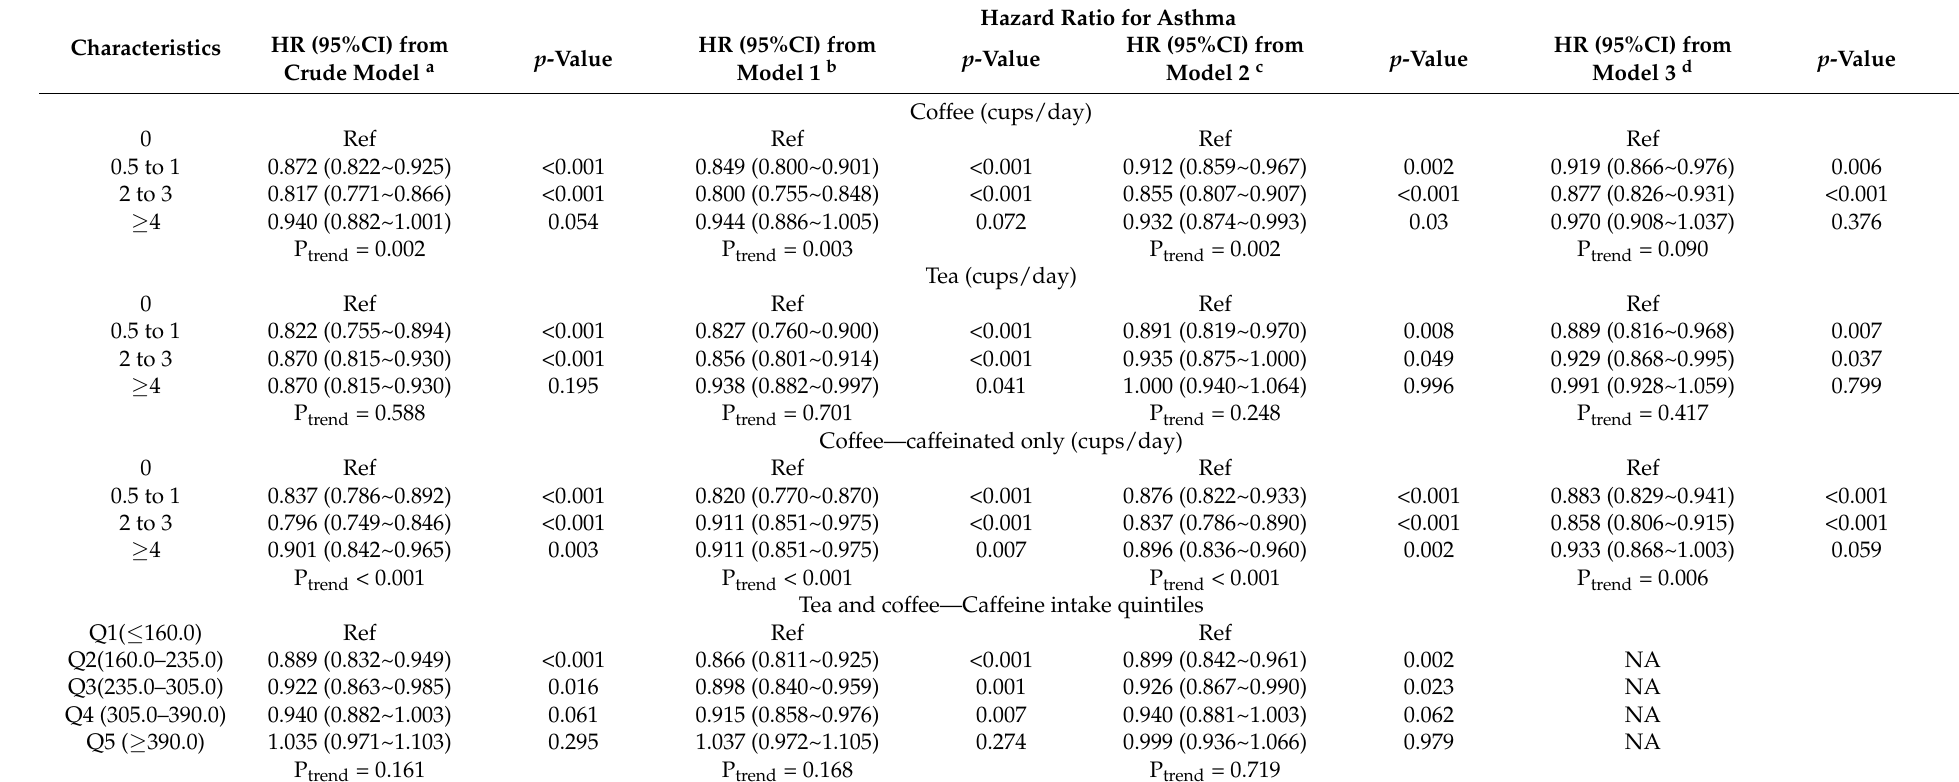
Table 2. Coffee and tea consumption in relation to asthma risk: UK